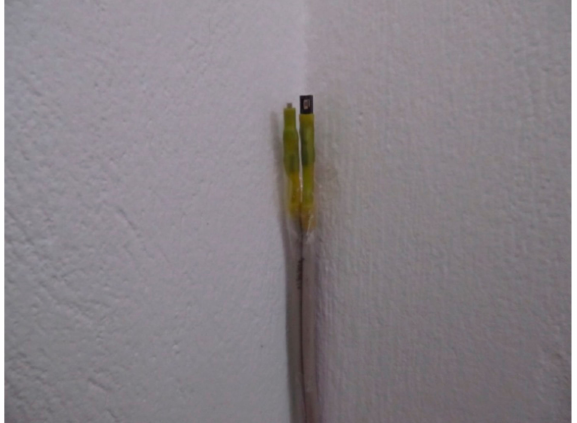
Figure 6. Installation of temperature (Pt-100) and humidity (HIH-4000) sensors in the external corner of the